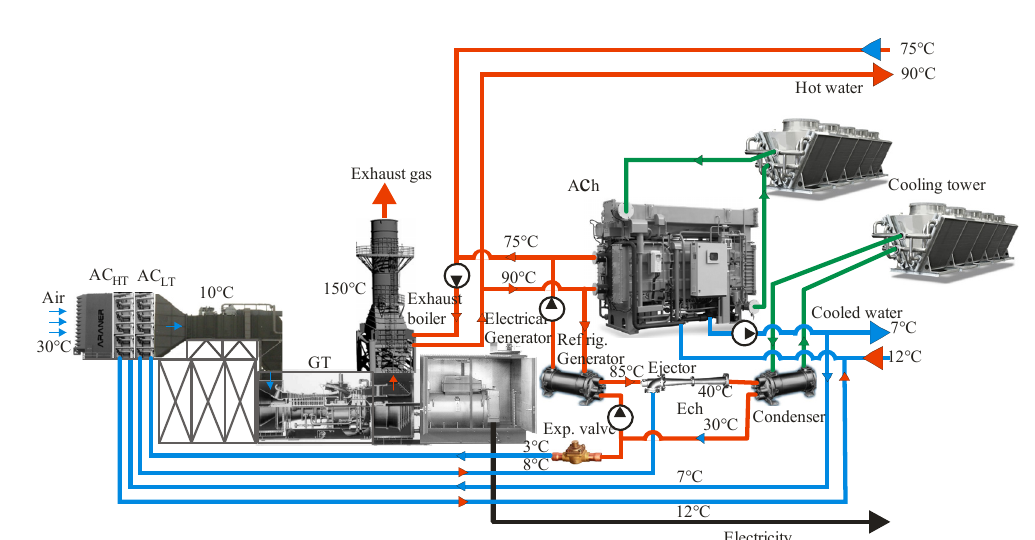
Figure 4. A scheme of two-stage gas turbine intake air cooling system in stage absorption-ejector chiller (SAECh): AC HT —high-temperature stage of air cooler; AC LT —low-temperature stage of air cooler;